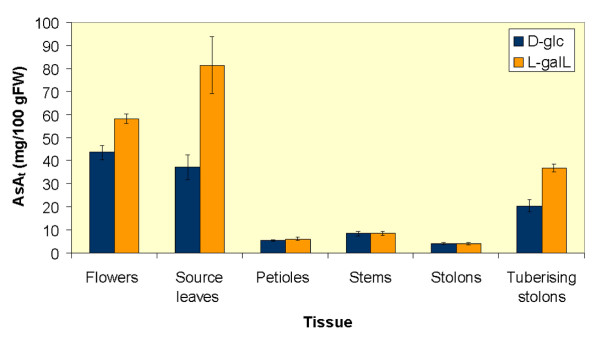
Effect of precursor supply to source leaves on AsAt content in sink tissues. Terminal leaflets of all leaves of the lower four nodes of each stem of four potato plants were incubated with 500 μl 20 mM MES pH 5.5, 2 mM CaCl2 alone (control) or containing 25 mM L-GalL for 24 h. At the end of incubation the indicated tissues were removed from plants, snap frozen in liquid nitrogen and lyophilised. After lyophilisation, tissues were powdered and extracted in 5% MPA, 5 mM TCEP (19:1 v/w) prior to estimation of the AsA content in each tissue by HPLC. Values are presented as means ± SE, n = 4.